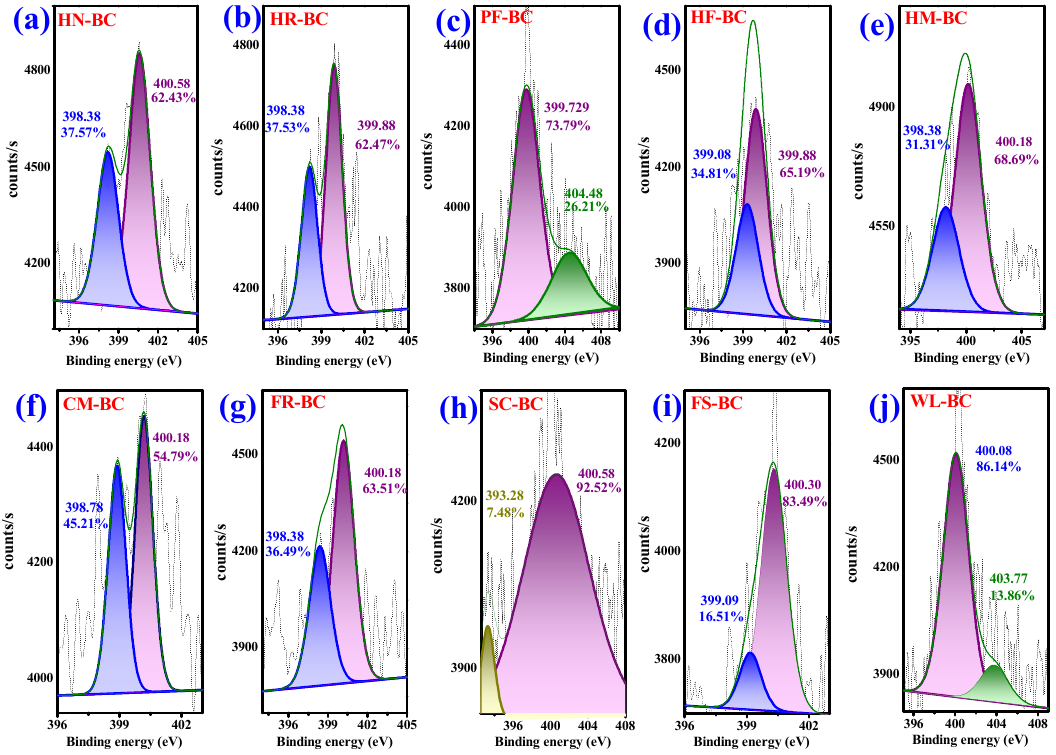
Figure 4. XPS spectra (N 1s) of AKWs-BC: HN-BC ( a ); HR-BC ( b ); PF-BC ( c ); HF-BC ( d ); HM-BC ( e ); CM-BC ( f ); FR-BC ( g ); SC-BC ( h ); FS-BC ( i ); WL-BC ( j